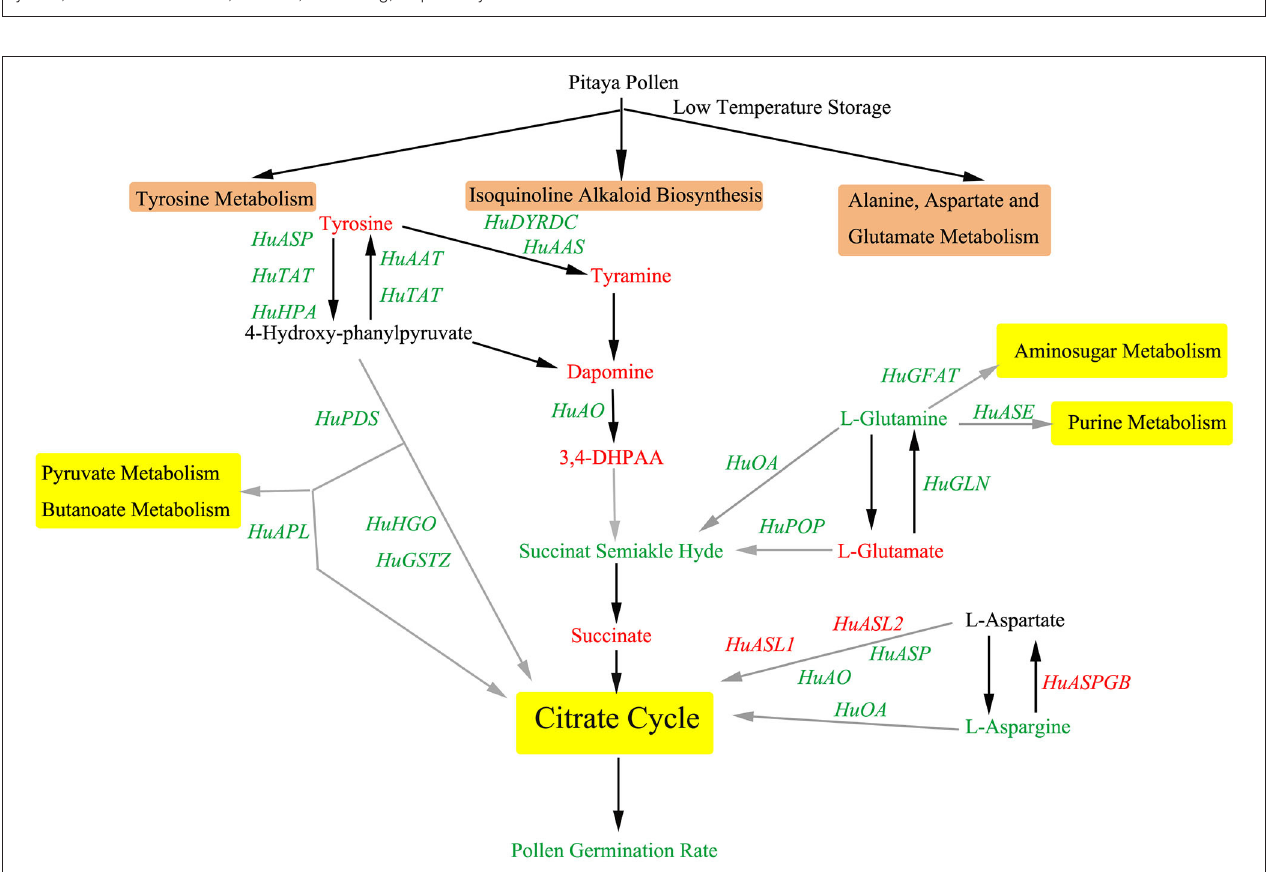
FIGURE 6 | in pitaya. KEGG pathway analysis depends on the transcriptomics data of pollen at different dates (0, 1, 2, and 3) stored at low temperatures. The Y-ordinate represents the transformation of the p -value, which was the statistical significance level of the KEGG pathway analysis, and the X-ordinate represents the importance of the pathway in the KEGG pathway analysis. Three key KEGG pathways were identified, including isoquinoline alkaloid biosynthesis, tyrosine metabolism, alanine, aspartate, and glutamate metabolism. Different colors stand for the importance of the pathway in low-temperature storage of pollen, white, yellow, and red means weak, medium, and strong, respectively.